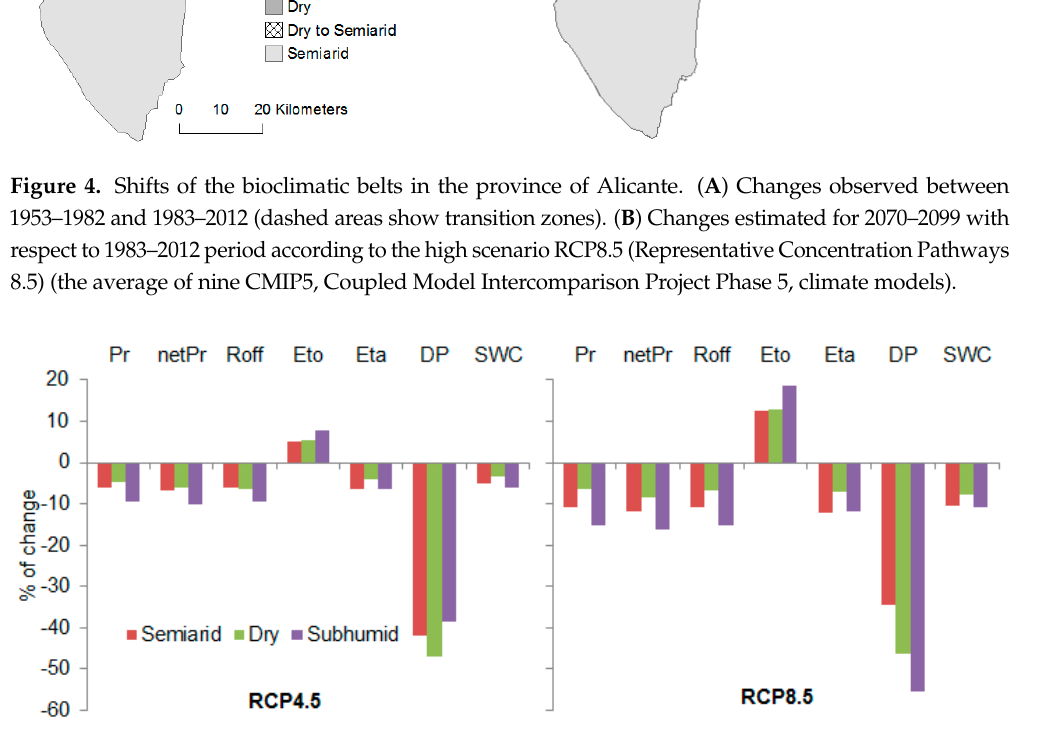
Figure 5. Percentage of change in the water balance components during the 30-year 2070–2099 period compared to 2010–2039 at the three pine sites along a climate gradient under the two RCP scenarios and in nine CMIP5 climate models. Pr: Precipitation, netPr: Net rainfall, Eto: reference evapotranspiration, Eta: actual evapotranspiration, DP: deep percolation, SWC: soil water content.